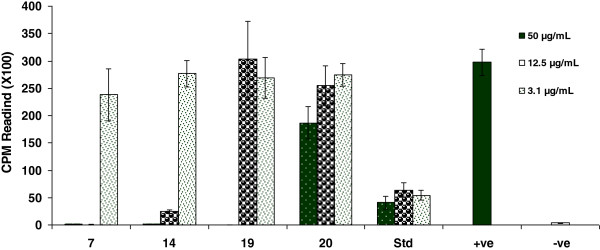
Represents toxic effect of compounds 5, 7, 14, 19 and 20 on PHA activated T-cells proliferation compared to prednisolone. T-cells were incubated with compounds/prednisolone for 24 hrs then washed and activated for further 72 hrs with PHA. The bars represent the level of T-cells proliferation compared to controls [cells + PHA (+ve) and cells without PHA (−ve)]. Each bar represents a mean of triplicate reading.